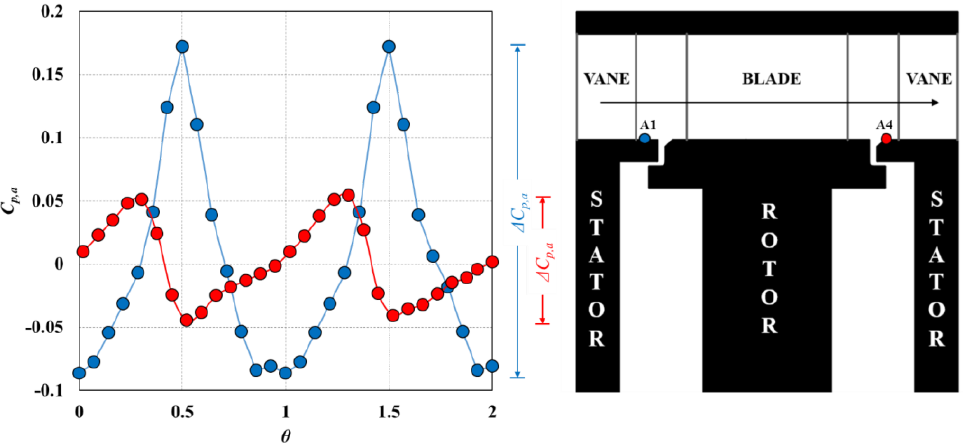
Figure 4. Non-dimensional pressure coefficient in the annulus, C p,a , at locations A1 and A4 ( C F = 0.29, Re φ = 7.2 × 10 5 , Φ 0 = 0).